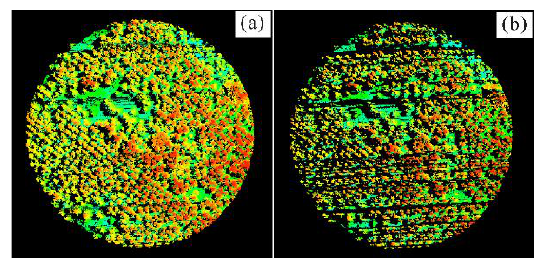
Figure 3. Point cloud filtering diagram, (a) before filtering, (b) after filtering